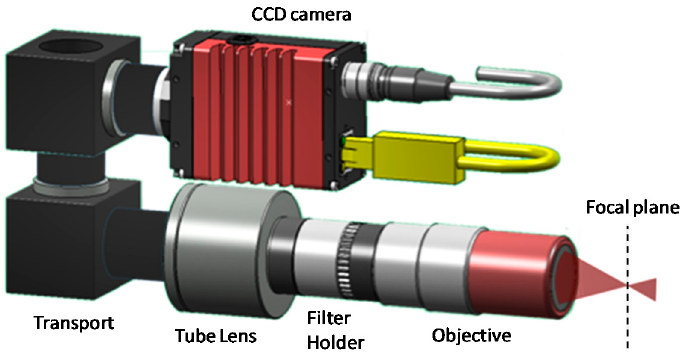
Figure 13. Design and experimental prototype of the module for focal spot quality and stability